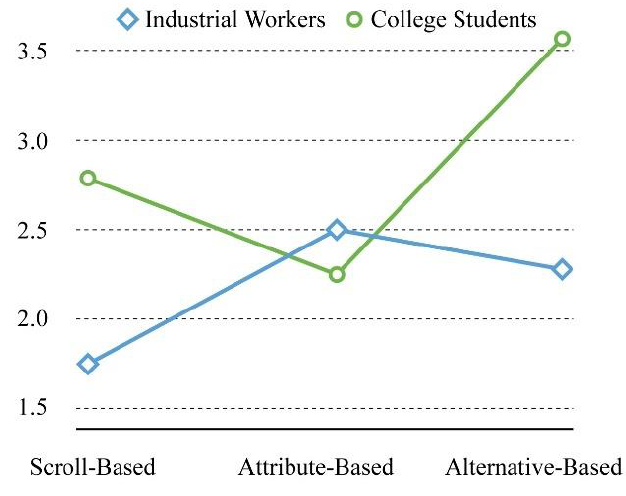
Figure 7. The interaction diagram regarding effort.